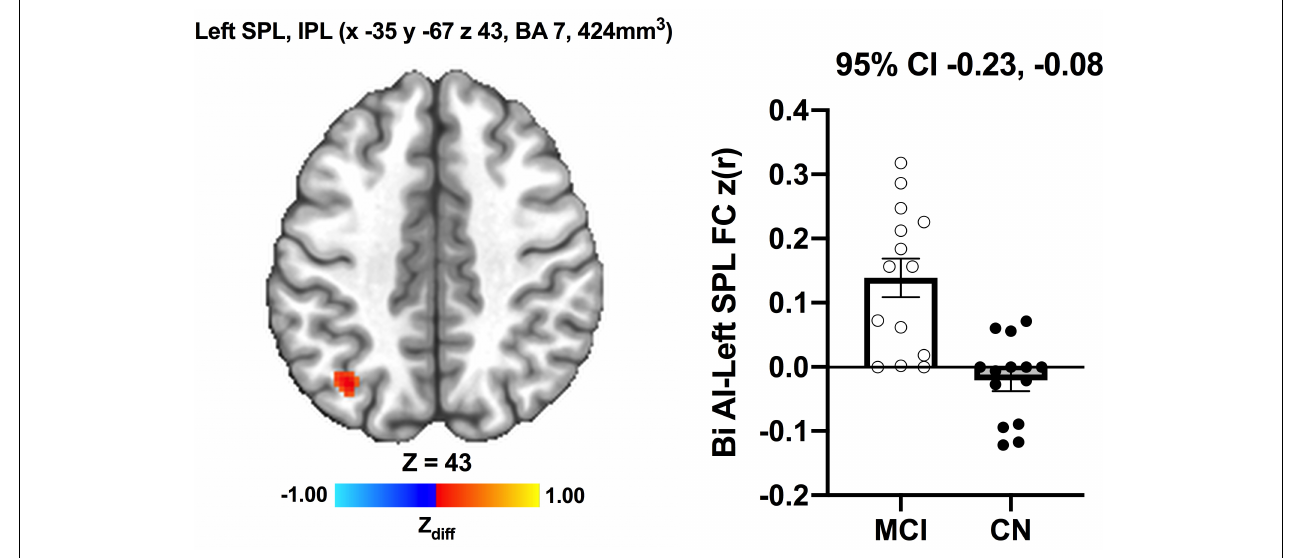
FIGURE 5 | Greater functional connectivity between the anterior insula and left superior parietal lobule and inferior parietal lobule were found after exercise training in individuals with MCI compared to individuals with CN. Adjacent bar graphs indicate the connectivity between the anterior insula and respective regions ( ± SEM) for after exercise training. 95% CI above bar graphs indicate 95% confidence interval in the group difference (CN vs